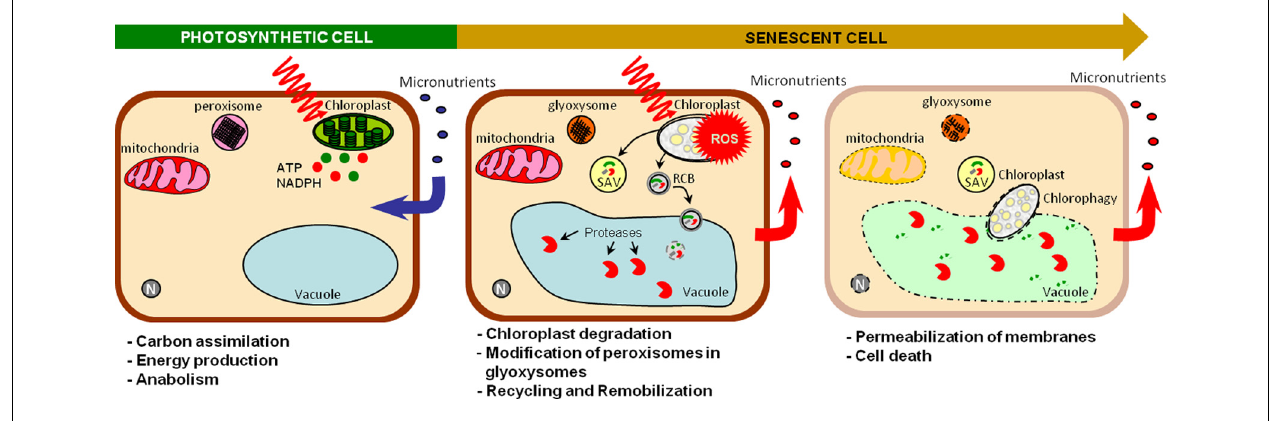
ATG-independent route which is not well understand yet (Hörtensteiner and Feller, 2002; Ishida etal., 2008; Ishida etal., 2013). These dismantling mechanisms decrease chloroplast seize enabling whole chloroplast degradation via chlorophagy (Ishida etal., 2013). Peroxisomes are modified to glyoxysomes, which produce energy and soluble sugars from lipid catabolism (Buchanan-Wollaston, 1997; del Rìo etal., 1998). Mitochondria that remain intact until late after senescence onset, are in turn degraded when the energy demand decreases (Yoshida, 2003). Finally, membrane permeabilization causes loss of cytoplasm that finally leads to death. ROS, reactive oxygen species; SAV, senescence-associated vacuoles; RCB, rubisco containing body; N,